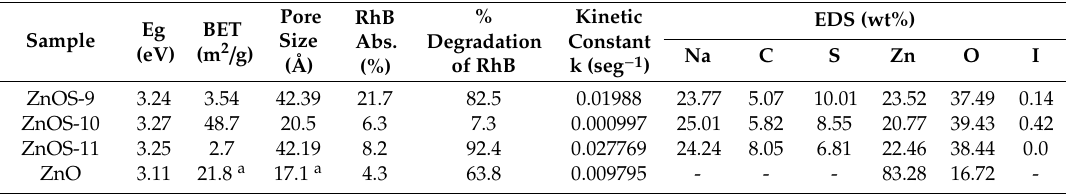
Table 1. Optical, structural, and photocatalytic characteristics of the ZnOS composite and ZnO.